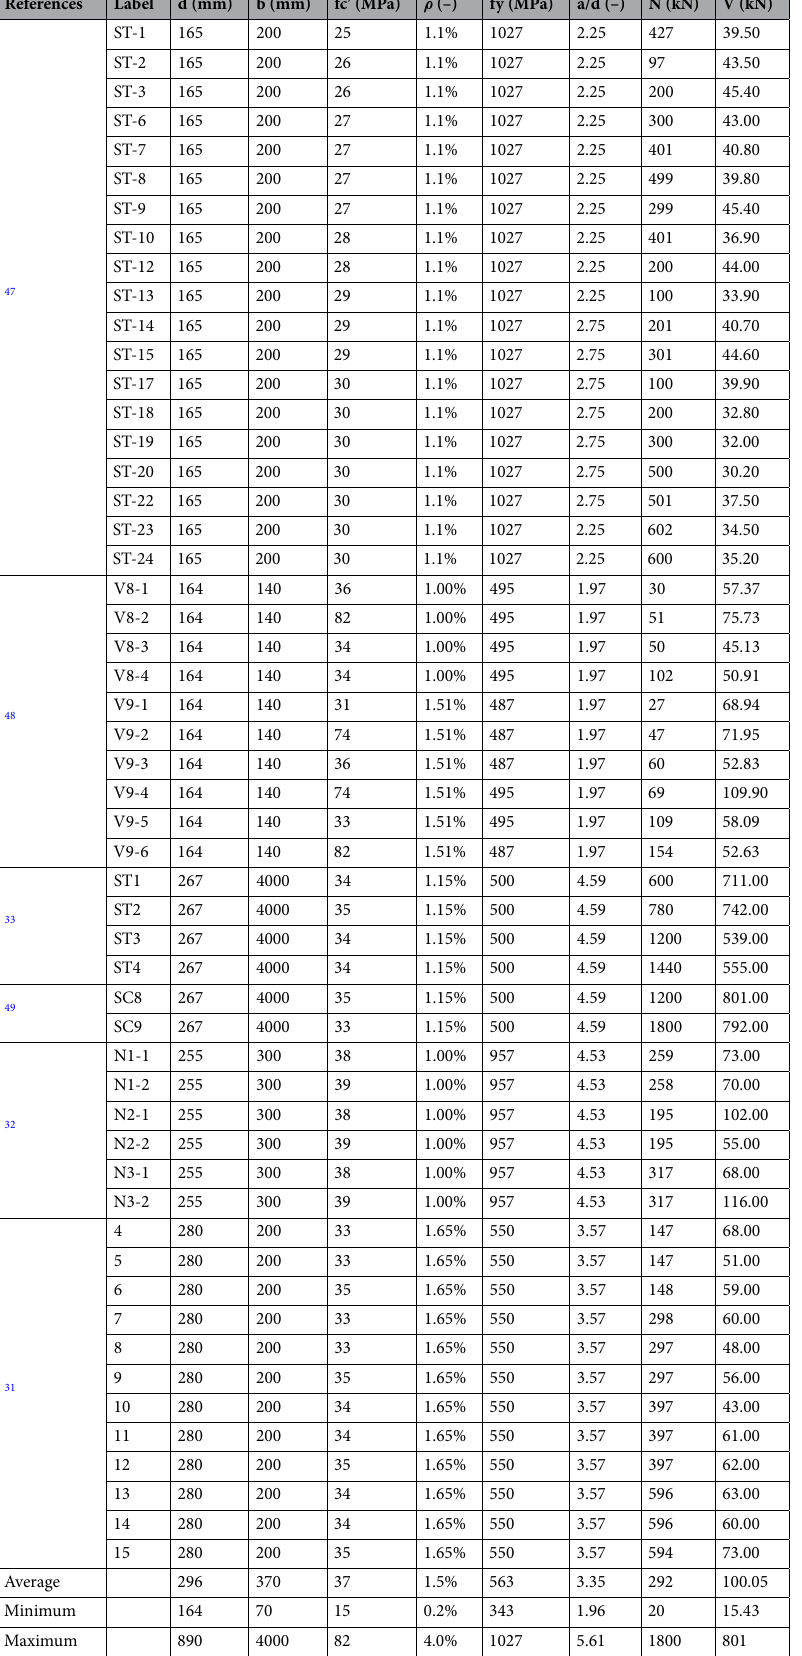
Table 1. Experimental